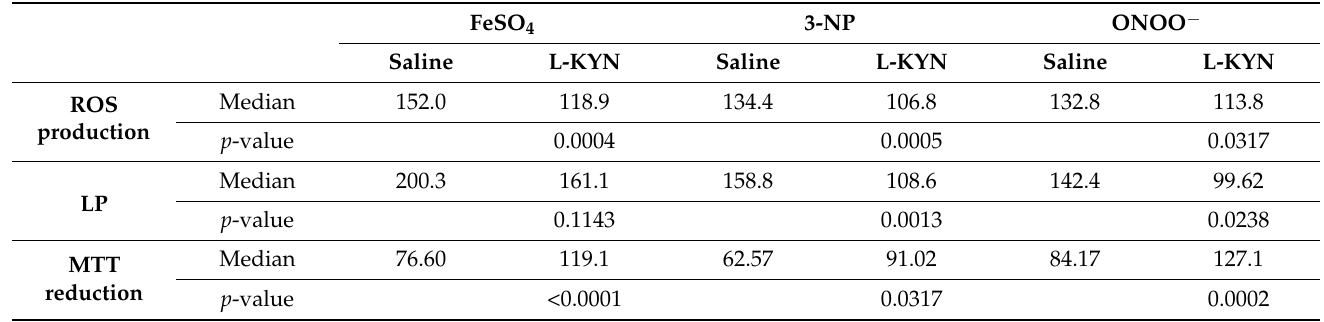
Table 6. Effect of sub-chronic administration of L-KYN on ROS production, reduction of LP and ROS production, LP and MTT reduction and p -values associated with the effect of L-KYN for each pro-oxidant vs. Saline group, compared using the Mann–Whitney